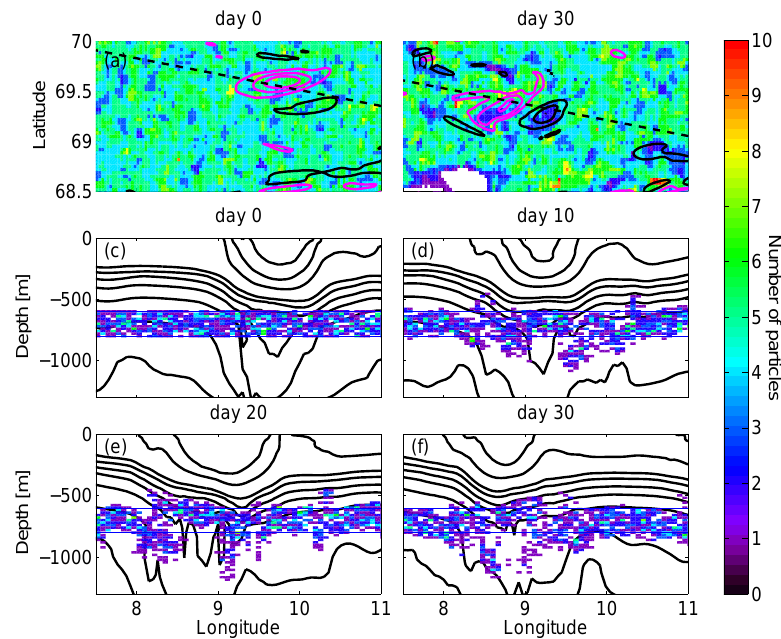
Fig. 6. The two upper panels show depth-integrated horizontal distribution of particles in experiment M3D on (a) day 0 and (b) day 30. The contours show vorticity in model layer 21 (depth: 437–616m), contour intervals are 1 × 10 − 5 s − 1 and pink is negative and black positive vorticity. The lower 4 panels show vertical distribution of particles along a section through the middle of the eddy on day (c) 0 (d) 10, (e) 20, and (f) 30. All particles in experiment M3D that were within 5km of the section were counted and the size of the pixels is 20m × 2.6km. The black contour lines in (c) – (f) are isopycnals. Since the eddy moves throughout the simulation, the position of the section followed the eddy, the positions of the section on day 0 and 30 are shown in (a) and (b)